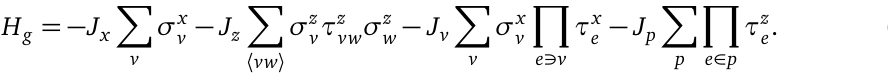
Figure 2: Gauging global Z symmetry in 2D. (a) Vertex A 2 = (cid:81) τ z quette B terms that appear in Eq. (2). (b-c) String p e ∈ p e